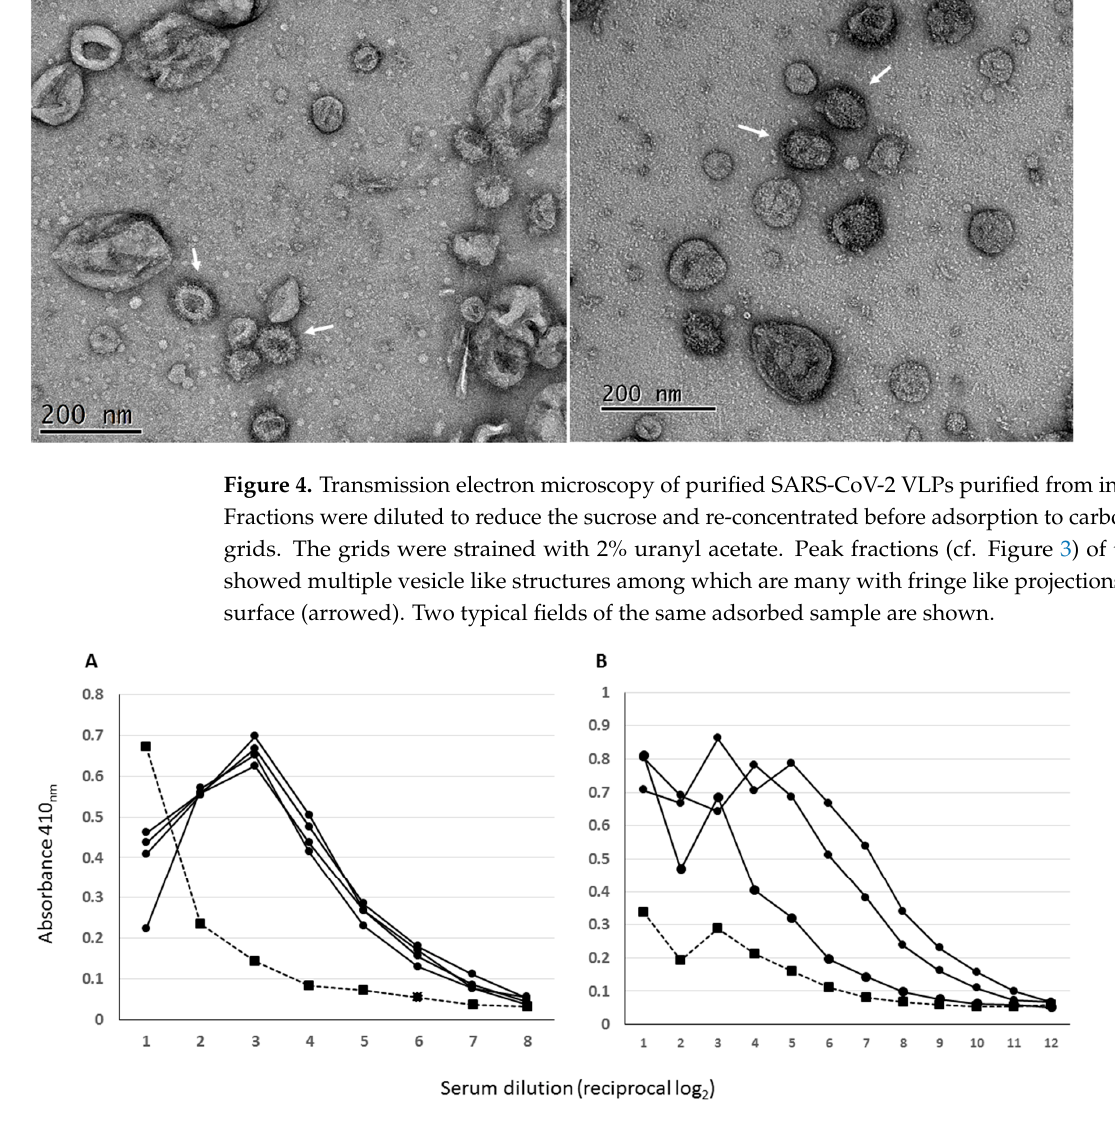
Figure 5. Antigenicity of SARS-CoV-2 VLPs determined by ELISA. Purified VLPs were adsorbed directly to the immunoplates overnight and blocked extensively before being probed with a twofold dilution series of pre-screened convalescent sera. Primary antibody binding was detected with an anti-human Ig HRP conjugate. ( A )—Sera pre-screened by ELISA on purified SARS-CoV-2 S1 protein. ( B )—Sera pre-screened by peptide array. In both assays filled circles and solid lines are sera that pre-screened positive while the single filled square dashed line is a negative. Some inhibition of binding at the high serum concentrations is apparent with the left panel serum set.